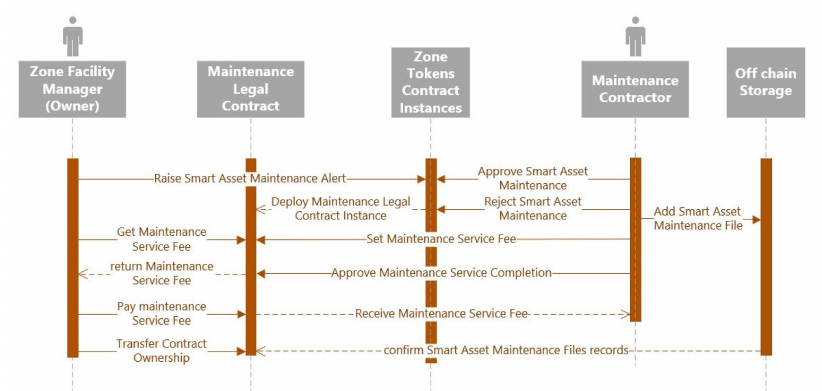
Figure 5. Sequence diagram of the BCDT cD smart